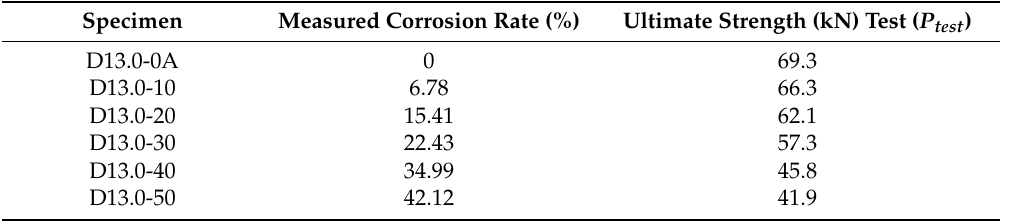
Table 8. Ultimate strengths for the D13.0 series push out test specimens.